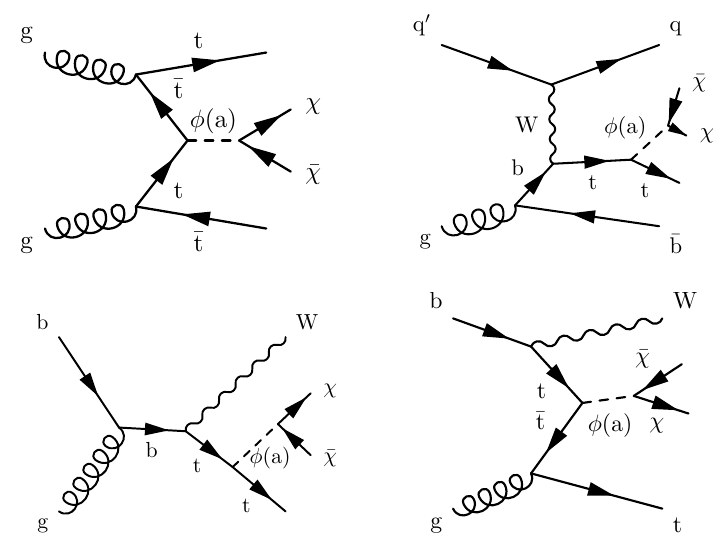
Figure 1 . Principal production diagrams for the associated production at the LHC of dark matter with a top quark pair (upper left) or a single top quark with associated t channel W boson production (upper right) or with associated tW production (lower left and